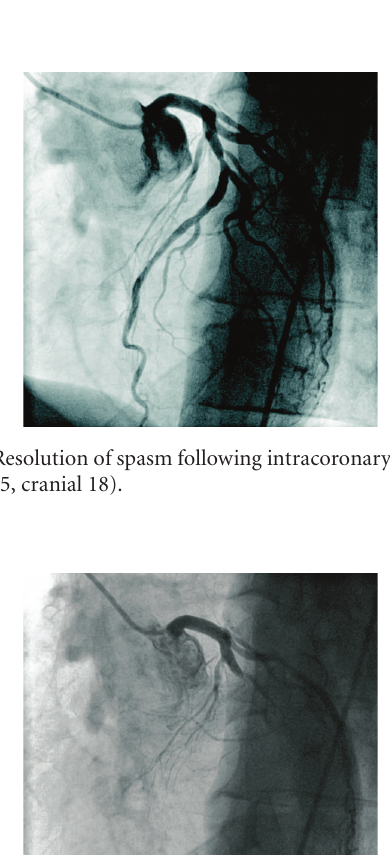
Figure 4: Spontaneous occlusion of the left anterior descending coronary artery (LAO 35, cranial 18) accompanied by ST-segment elevation.